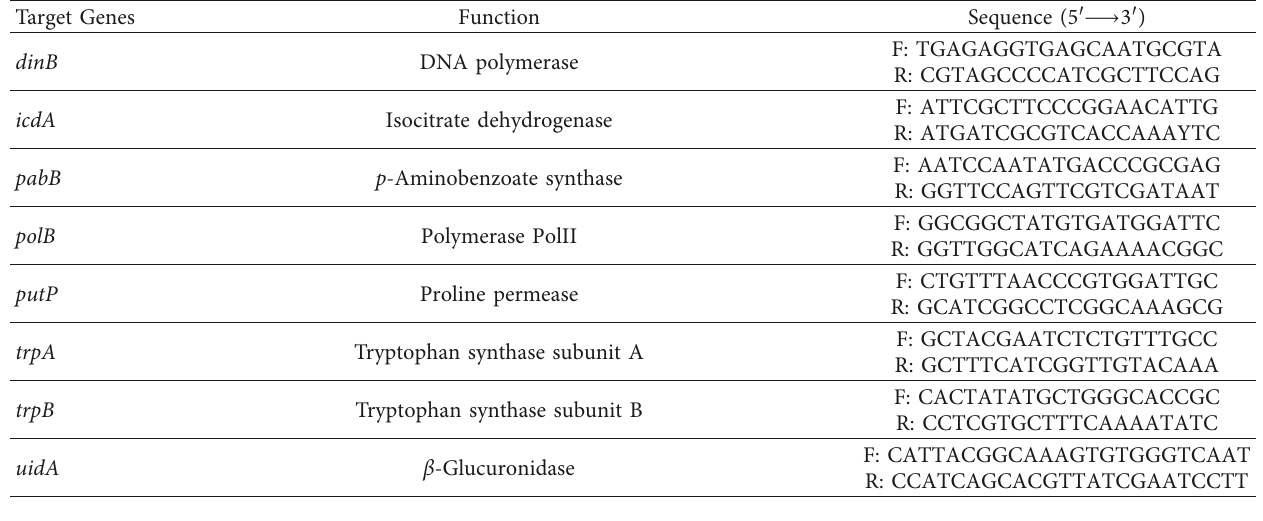
Table 2: Average microbial load of children’s stools by age.